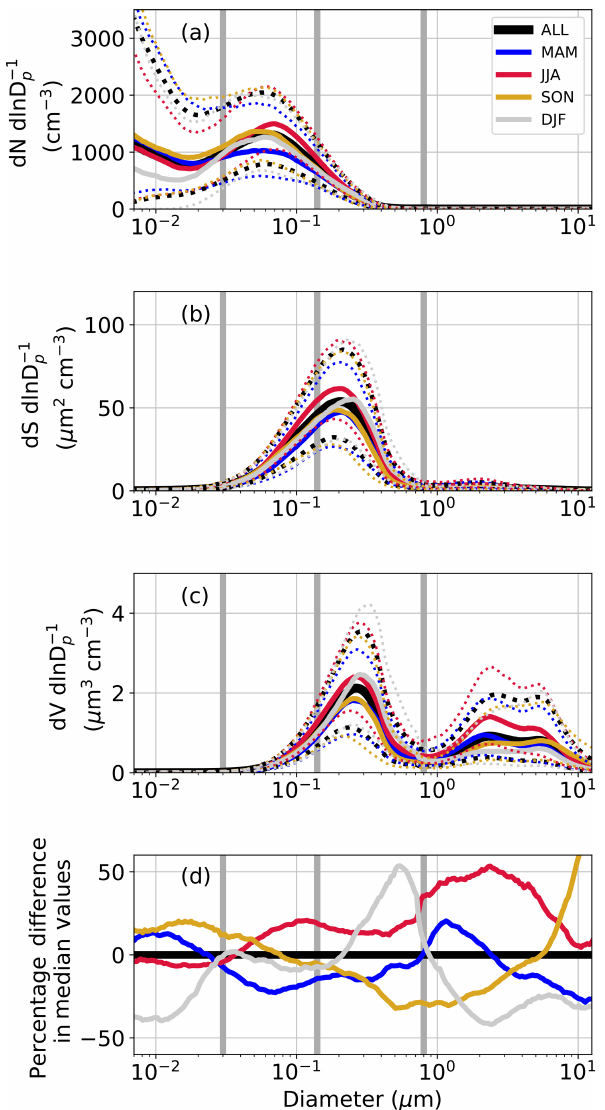
Figure 2. Aerosol size distributions for the entire time period and by season. (a) represents the number size distributions (cm − 3 ), (b) rep- resents the surface area size distributions (µm 2 cm − 3 ), and (c) rep- resents the volume size distributions (µm 3 cm − 3 ). The solid colored lines depict the median values, and the dotted lines depict the 25th and 75th percentiles. (d) represents the percentage difference in the median size distributions for each season with respect to the entire period (ALL). The vertical gray lines demarcate the four separate regions of the size distribution that were used for further analyses in this study.